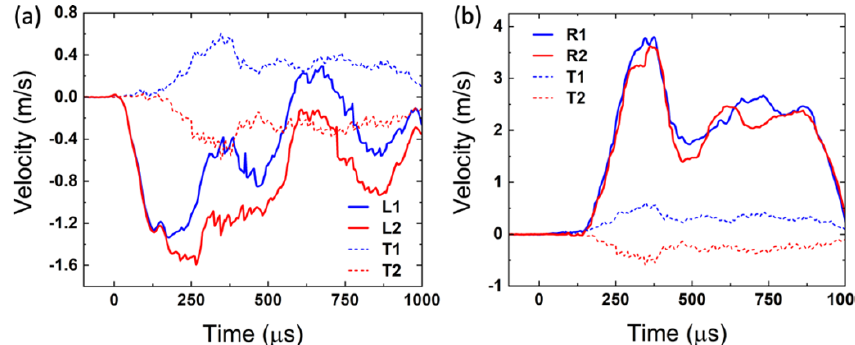
Fig. 3. PDV velocity measurements made by the three pairs of probes located on the input bar, where: (a) L1 and L2 are the longitudinal velocity profiles, and T1 and T2 are the transverse velocity profiles, (b) R1 and R2 are the rotational velocity profiles, and T1 and T2 are the transverse velocity